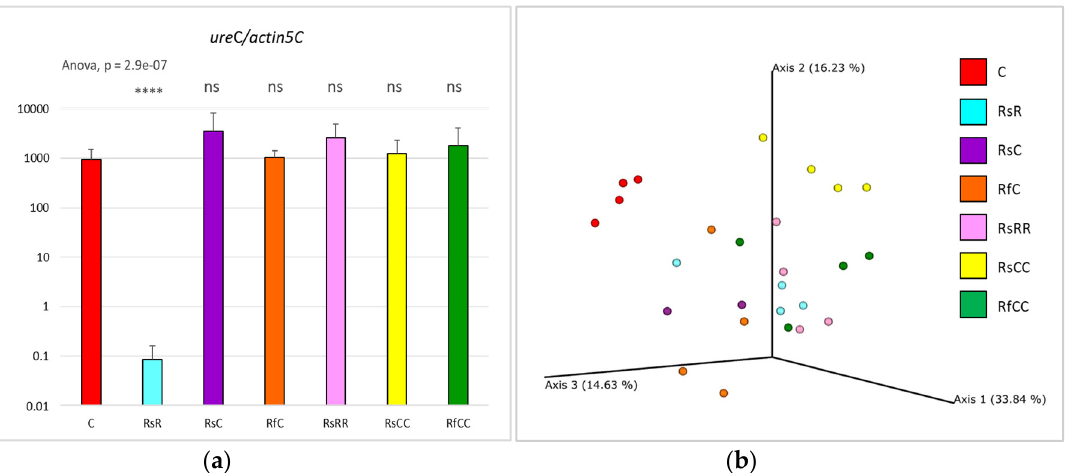
Figure 2. Effects of the rifampicin treatment on the two symbiotic systems of B. germanica . ( a ) Relative quantification of the endosymbiont in the fat body. Ratio ure C /actin5C in each sample of the analysed populations. ANOVA test comparing all the samples as a global p -value is shown in top left, and t-test values comparing each experimental sample to the control are shown above the bars (ns, p > 0.05; ****, p < = 0.0001). ( b ) PCoA analysis of the gut microbiota based on weighted UniFrac distances classified by sample type, indicating, on the axes, the percentages of variation explained by the principal coordinates.